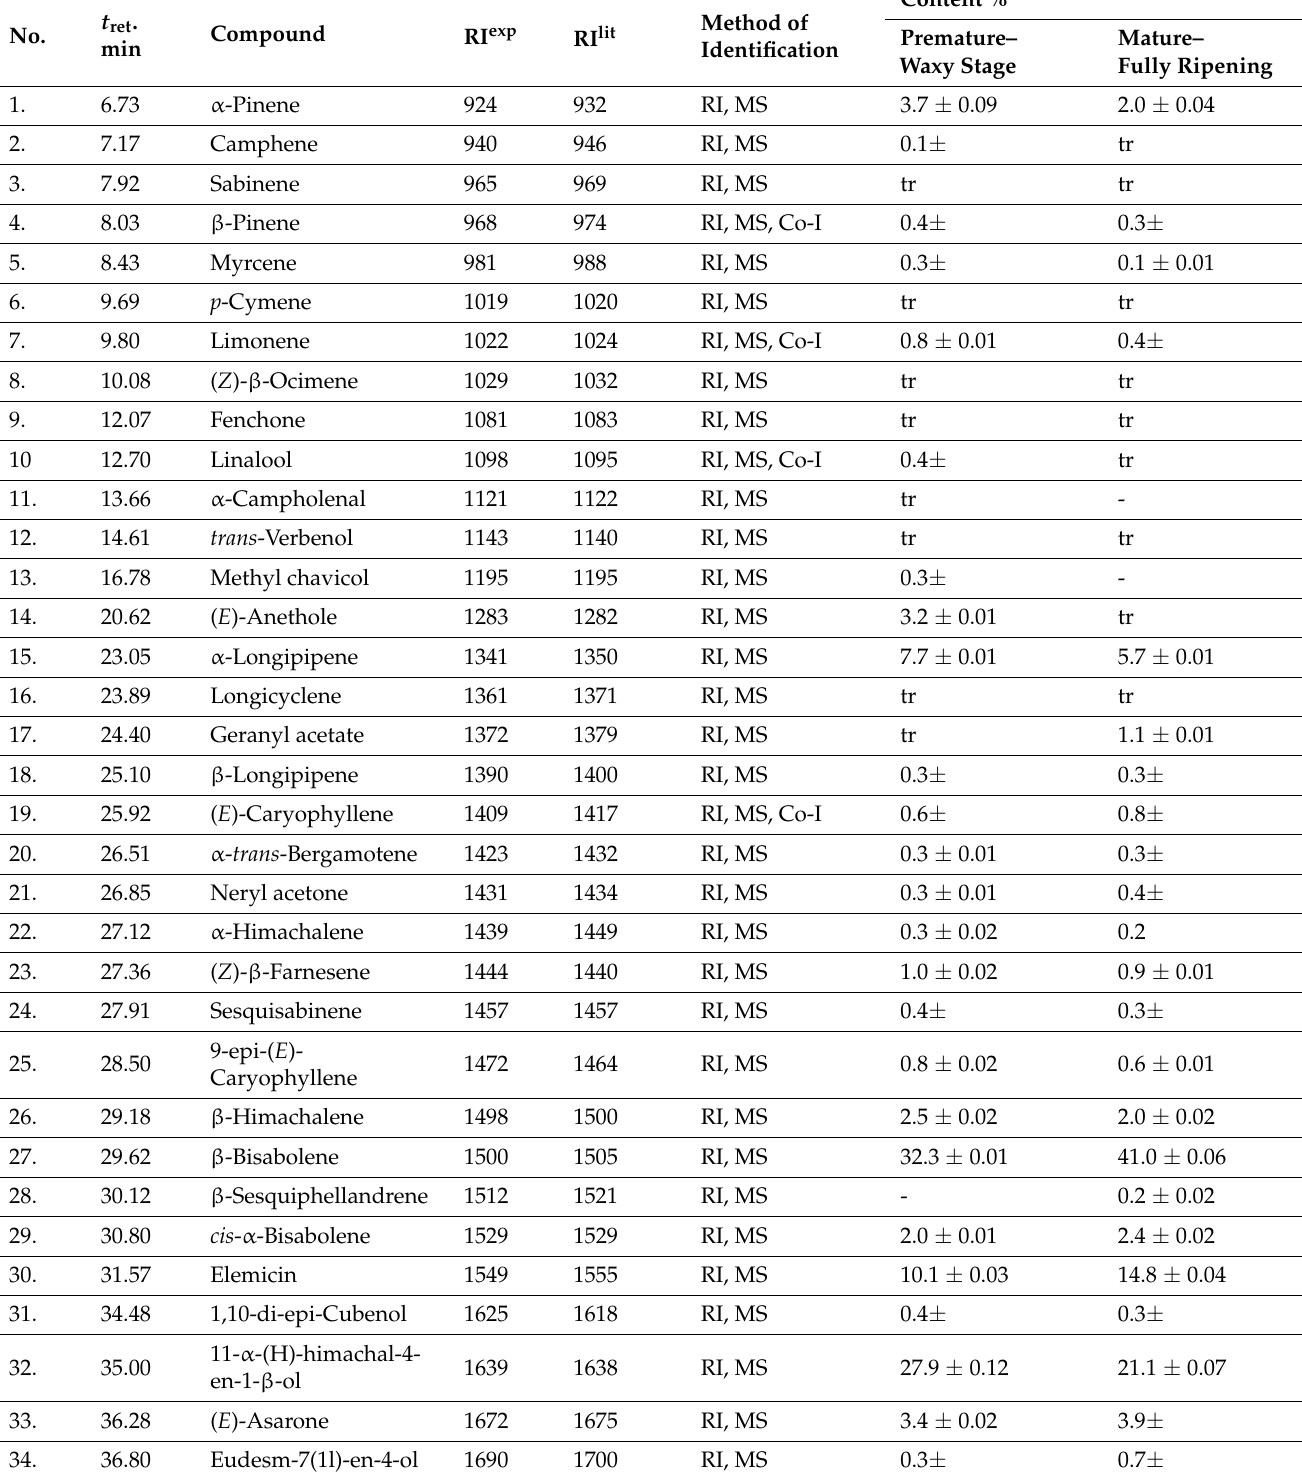
Table 1. Chemical composition of EO isolated from wild carrot umbels at different maturity